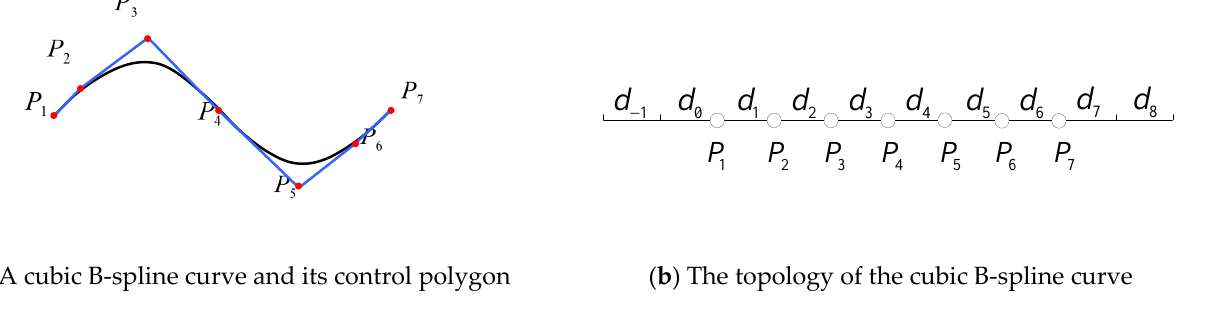
Figure 3. A cubic B-spline curve and its topology.